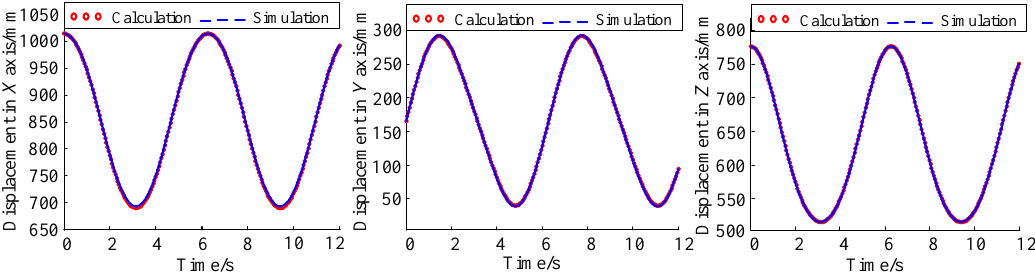
Figure 8. Three axis comparisons of end point motion results.